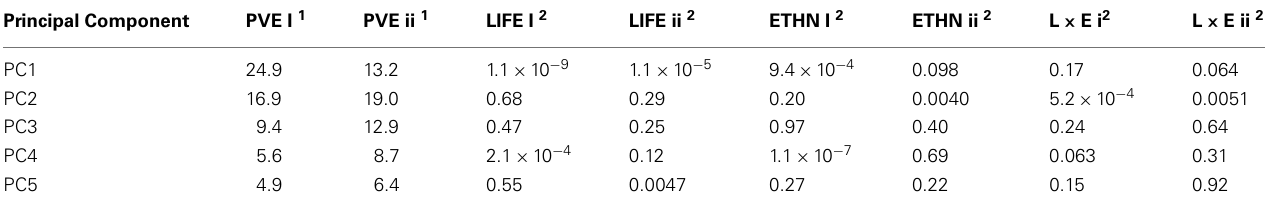
Table 1 | Principal components of fluidigm gene expression